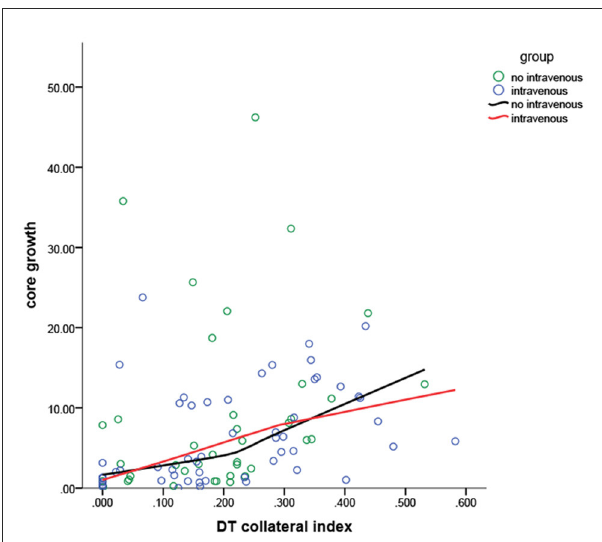
FIGURE2 The core growth rate in different collateral indexes for the patients in the two groups. The IVT and non-IVT groups intersected two times, which suggested a significant interaction between the IVT and the collateral index, indicating that both of them interfere significantly with the core growth rate. The line of the non-IVT group showed a major increase when the DT collateral index was 0.250.